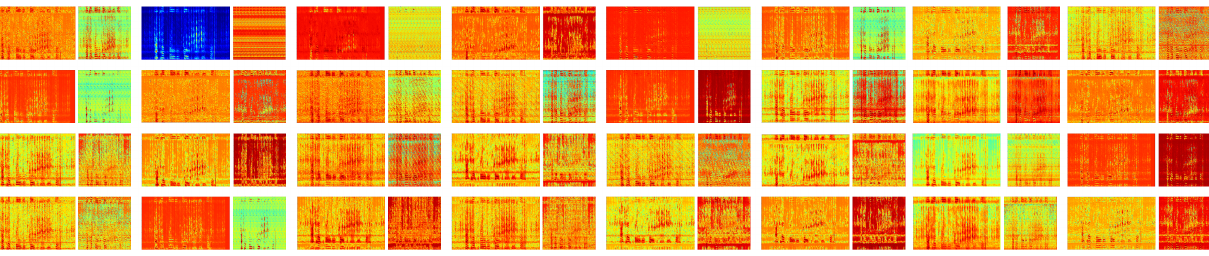
Figure 12. The spectrograms of 32 randomly selected convolution filters (wider spectrogram) and the PReLU activation outputs for the first hidden layer of the CNN architecture b , for a processed noisy